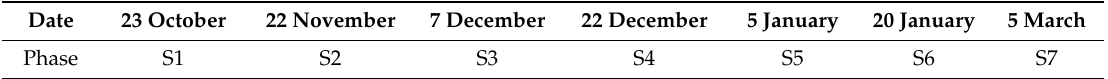
Table 1. Sampling time corresponding to